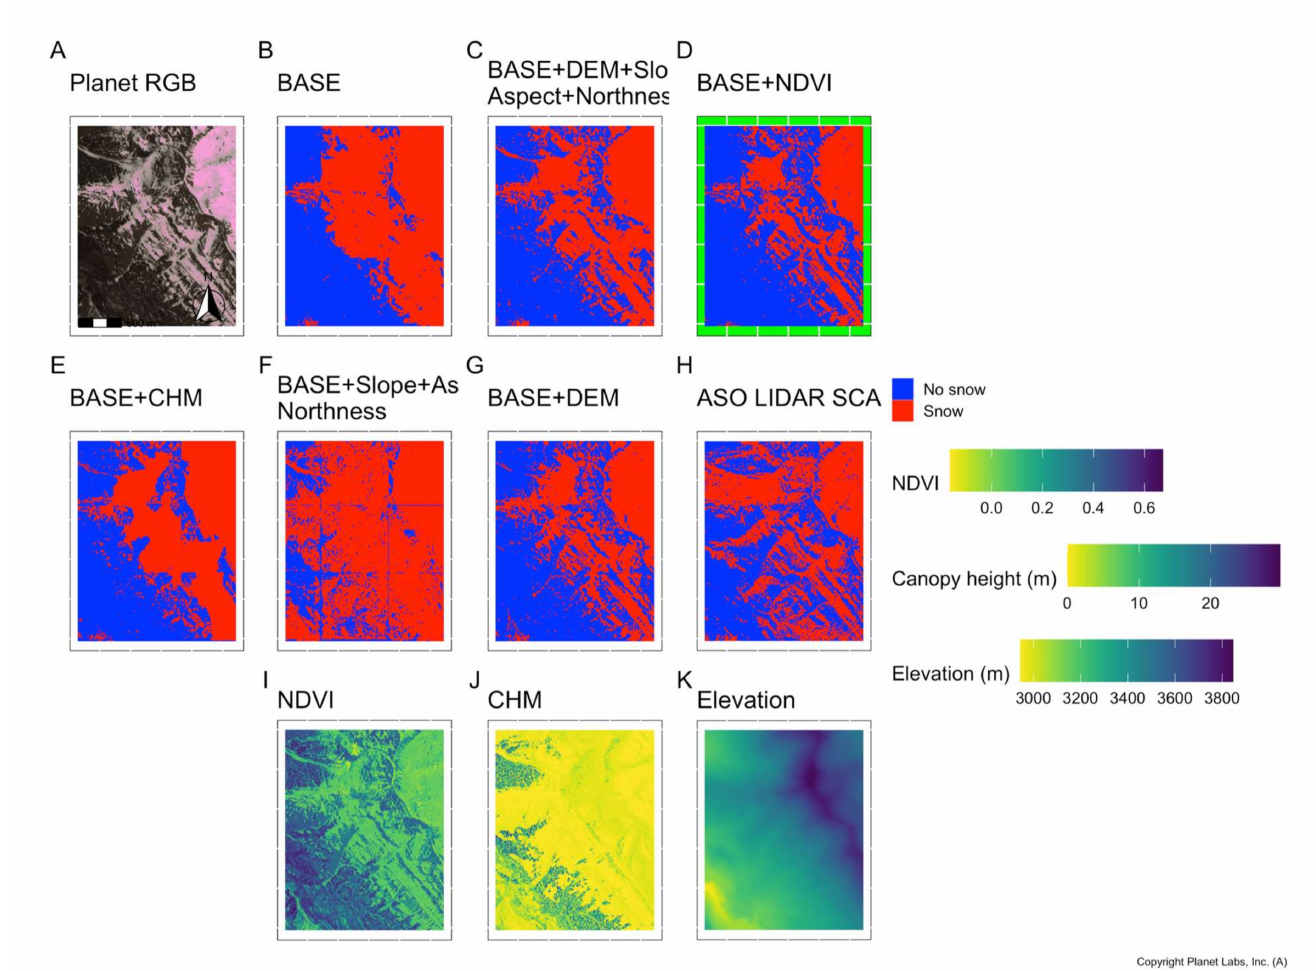
Figure 7. Performance of models in a sample area in Gunnison, which is in dense canopy and has canopy edges and open areas. ( A ) Planet RGB imagery showing the sample area in the Gunnison study site. ( B ) SCA predicted by the BASE model. ( C ) SCA predicted by the BASE + DEM (Elevation) + slope + aspect + northness model. ( D ) SCA predicted by the BASE + NDVI mode, the best performing model. ( E ) SCA predicted by the BASE + CHM model. ( F ) SCA predicted by the BASE + slope + aspect + northness. ( G ) SCA predicted by the BASE + DEM. ( H ) Lidar-derived SCA. Total study area of approximately 6.25 km 2 . The highlighted model in green is the overall best model, Model 1. ( I ) Corresponding NDVI of the large study area derived from PlanetScope image. ( J ) Canopy height of the study area that shows the density in canopy cover. ( K ) Elevation of the study area. Note that the tiles were aggregated for this visualization and show some visible artifacts (border lines). The satellite imagery in panel ( A ) was downloaded from Planet Labs, Inc. All rights